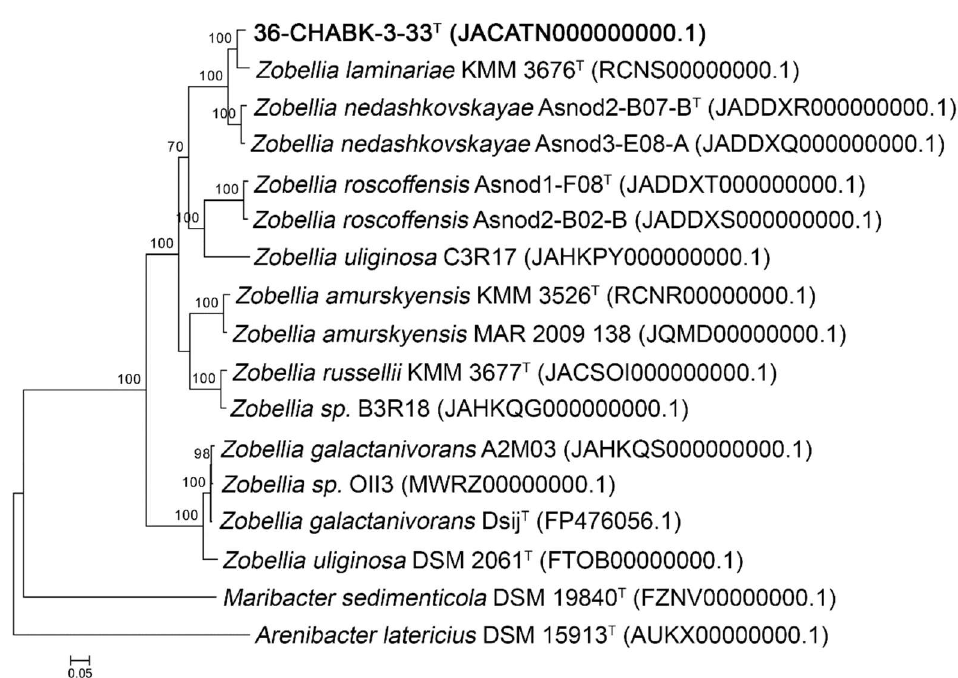
Figure 3. Maximum-likelihood phylogeny of available genomes of the genus Zobellia and strain 36-CHABK-3-33 T based on 400 universal markers selected by PhyloPhlAn3.0 and reconstructed by RAxML with non-parametric bootstrapping using 100 replicates including Bar, 0.05 substitutions per amino acid position.